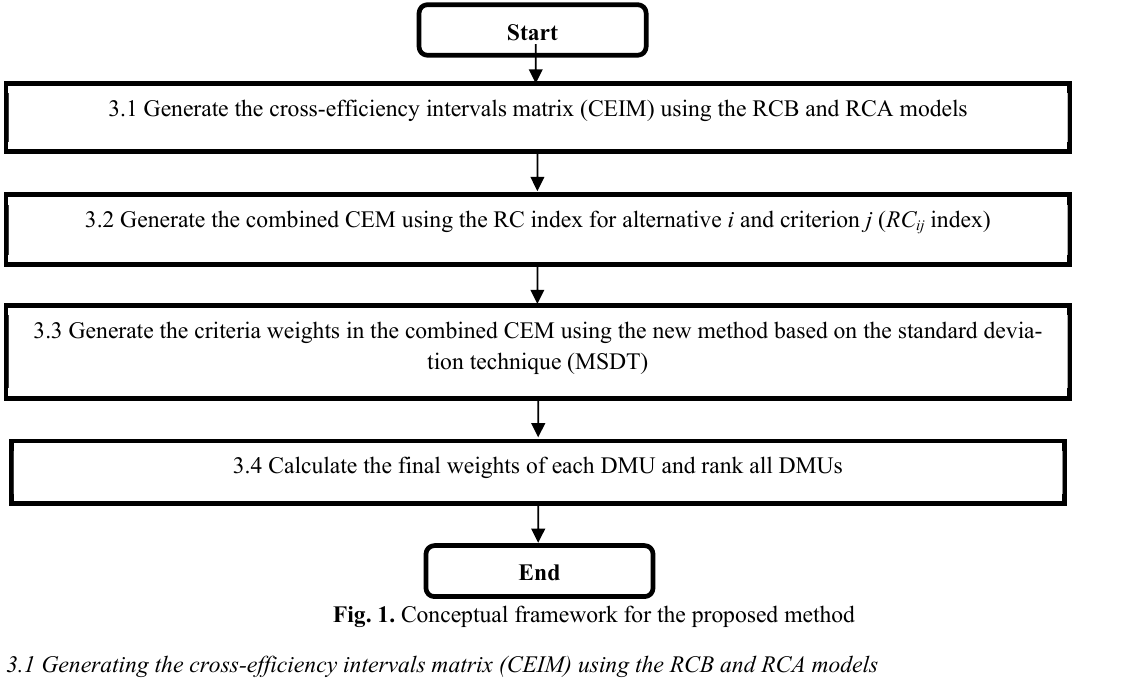
Fig. 1. Conceptual framework for the proposed